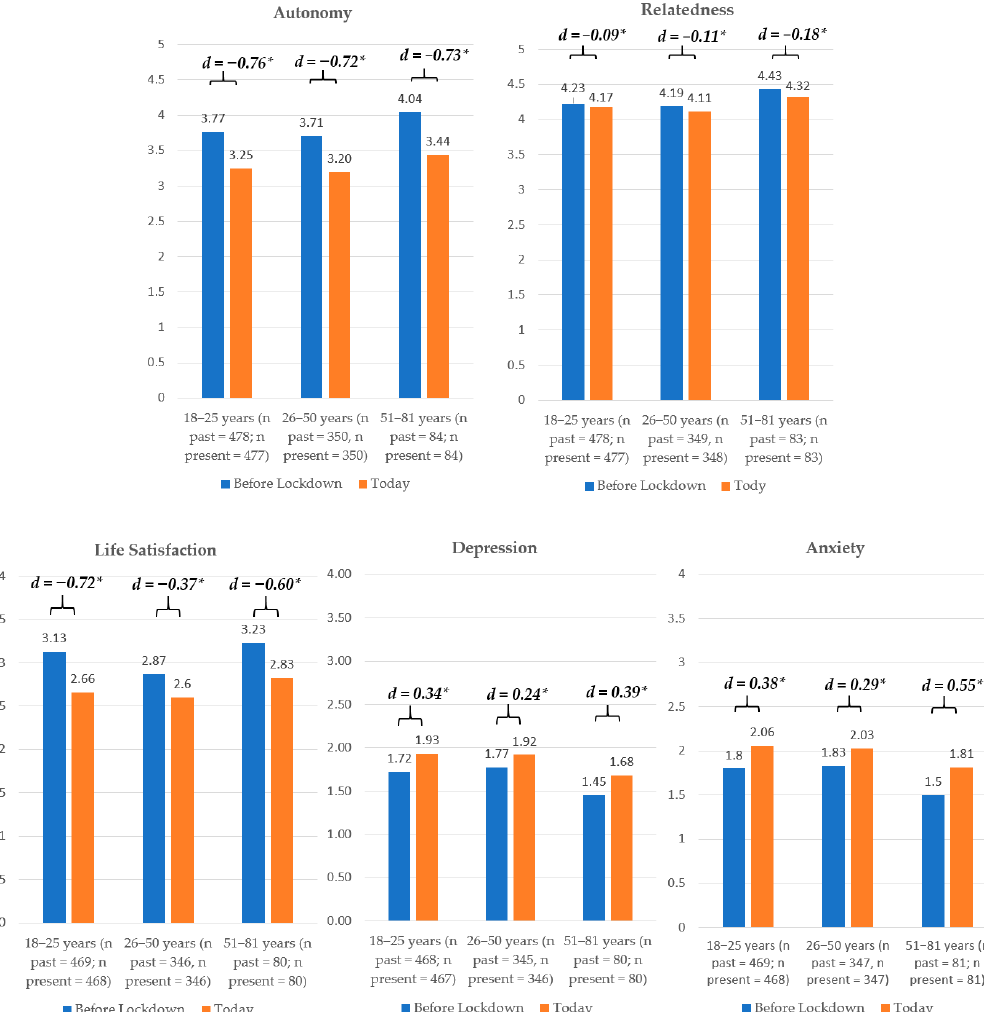
Figure 2. Differential Changes in Respective Age Groups. d = Cohen’s d (effect size), * p < 0.05. Figure 2. Di ff erential Changes in Respective Age Groups. d = Cohen’s d (e ff ect size), * p <